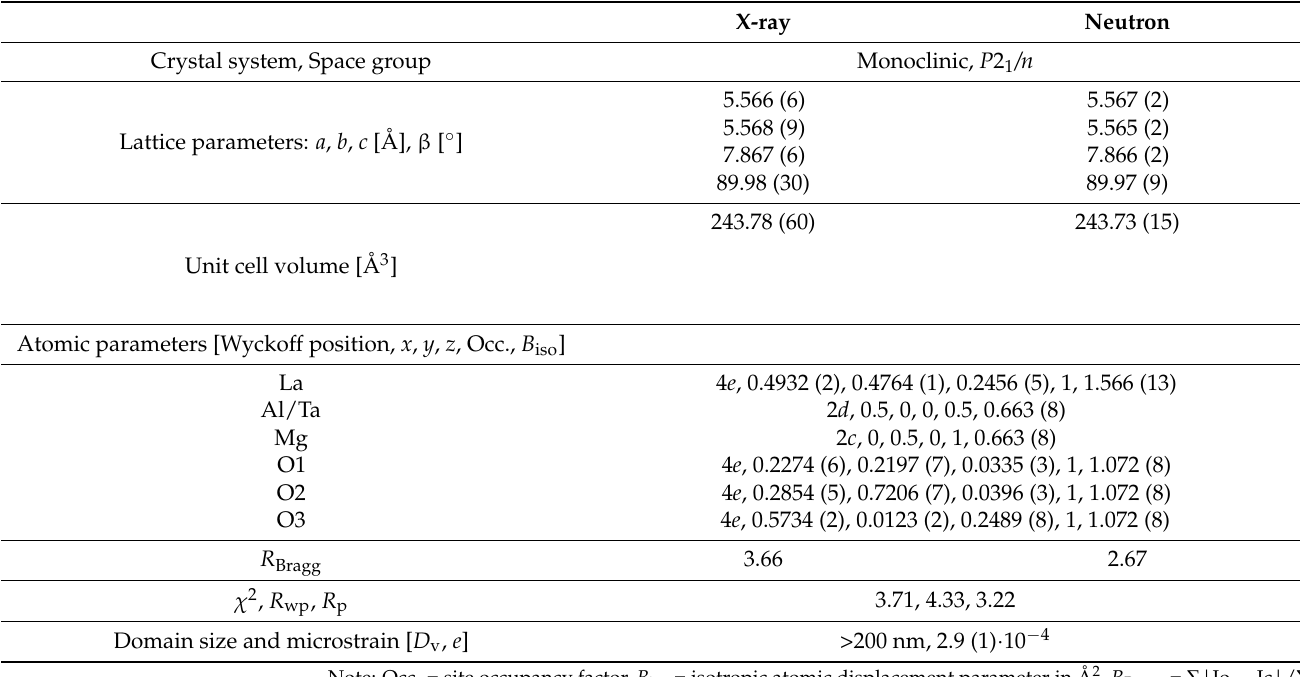
Table 1. Results of combined Rietveld analysis on LAMT.